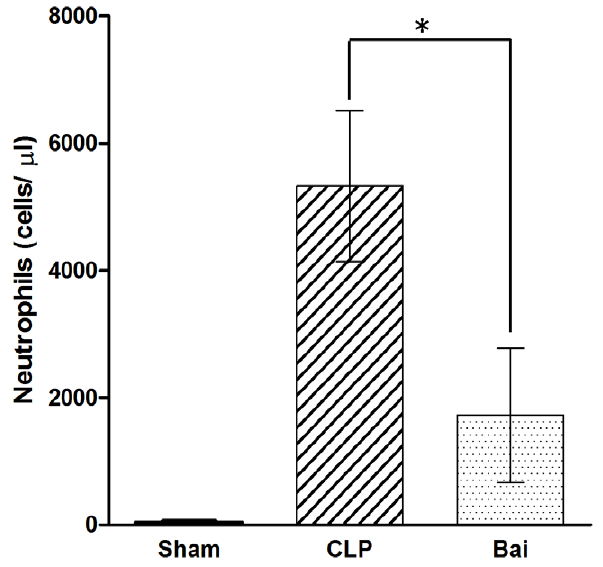
Figure 3. The number of neutrophils in peritoneum in septic mice after administration of baicalin. Baicalin reduced the number of neutrophils in peritoneum. Peritoneal lavage fluid were harvested 24 h after CLP. Bai, baicalin group; CLP, CLP group. Data analyses with one-way ANOVA and Newman-Keuls. * P , 0.05.